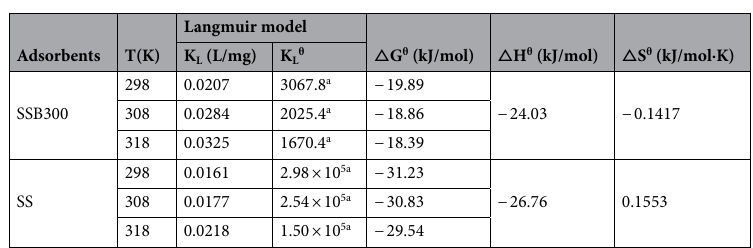
Table 5. The adsorption thermodynamic parameters of ammonium. a When calculating the molar concentration of the adsorbent, the molecular weights of SS300 and SS were assumed to be the molecular weight of C (12 g/mol).